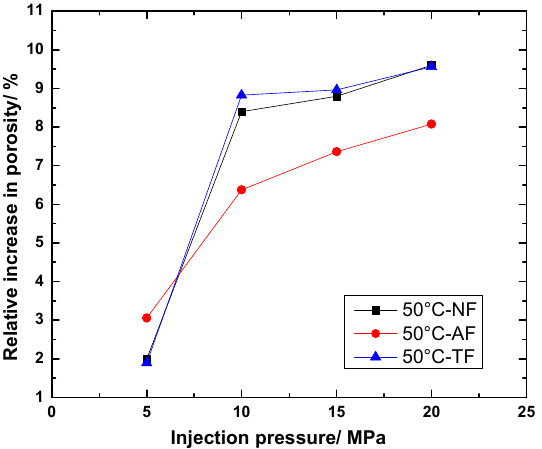
Figure 13. Relative increase in final porosity for the same action time and temperature.